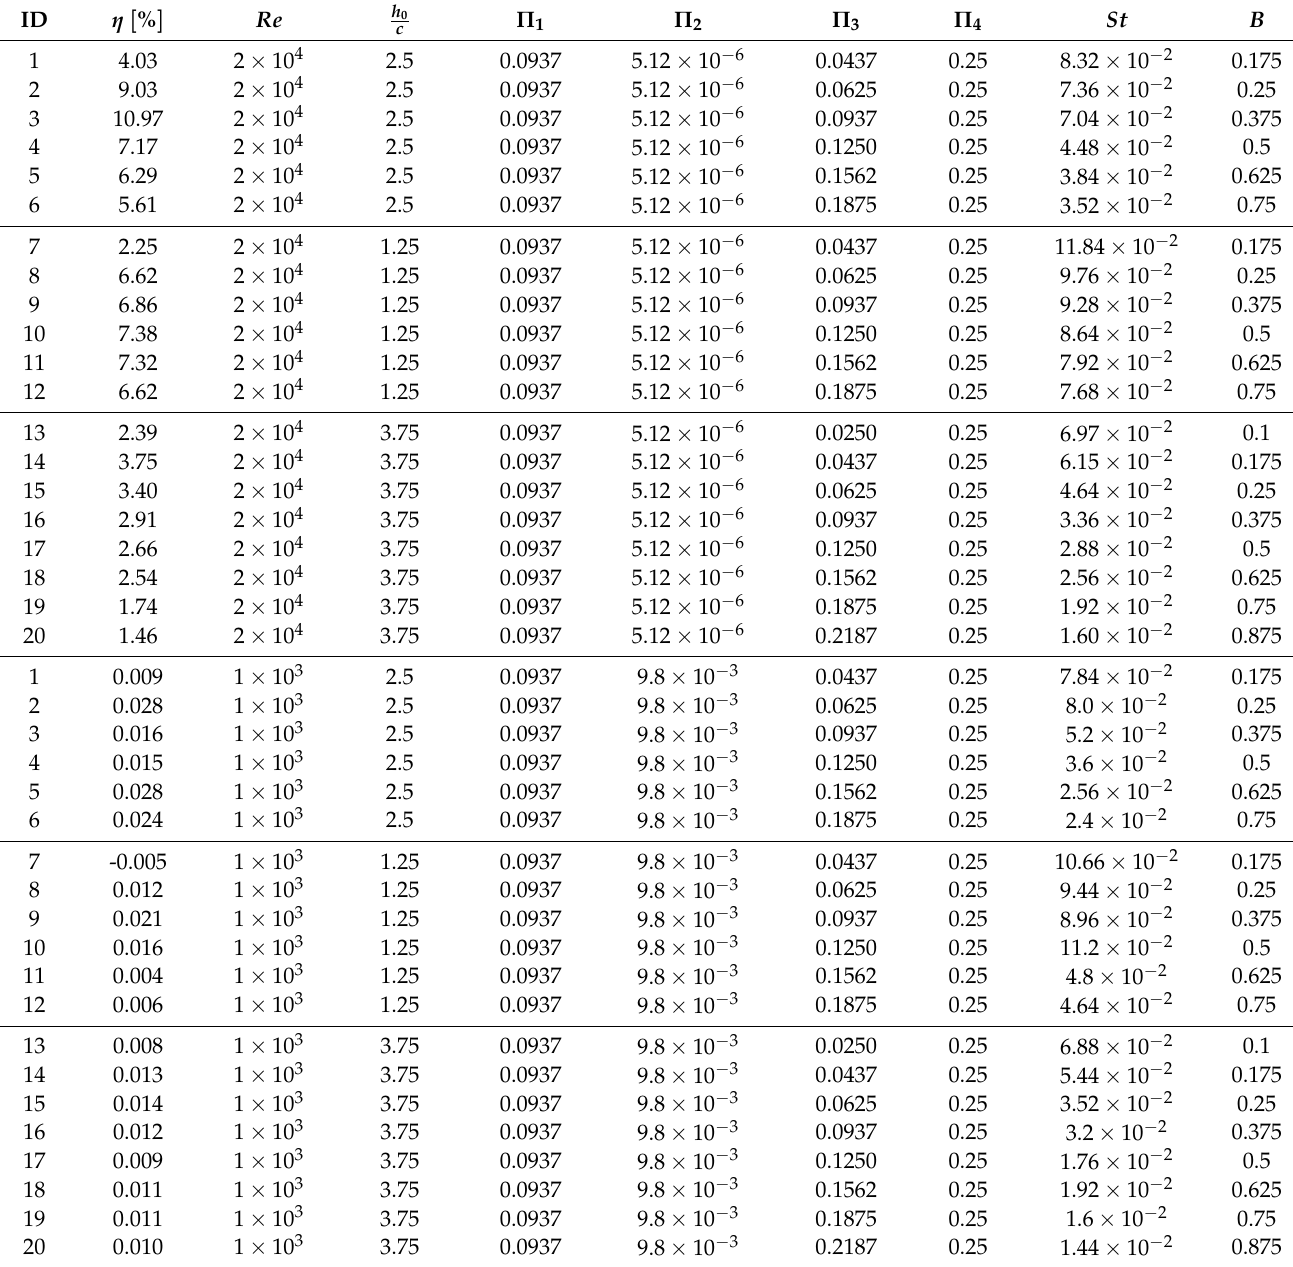
Table A4. Dimensionless parameters matrix.